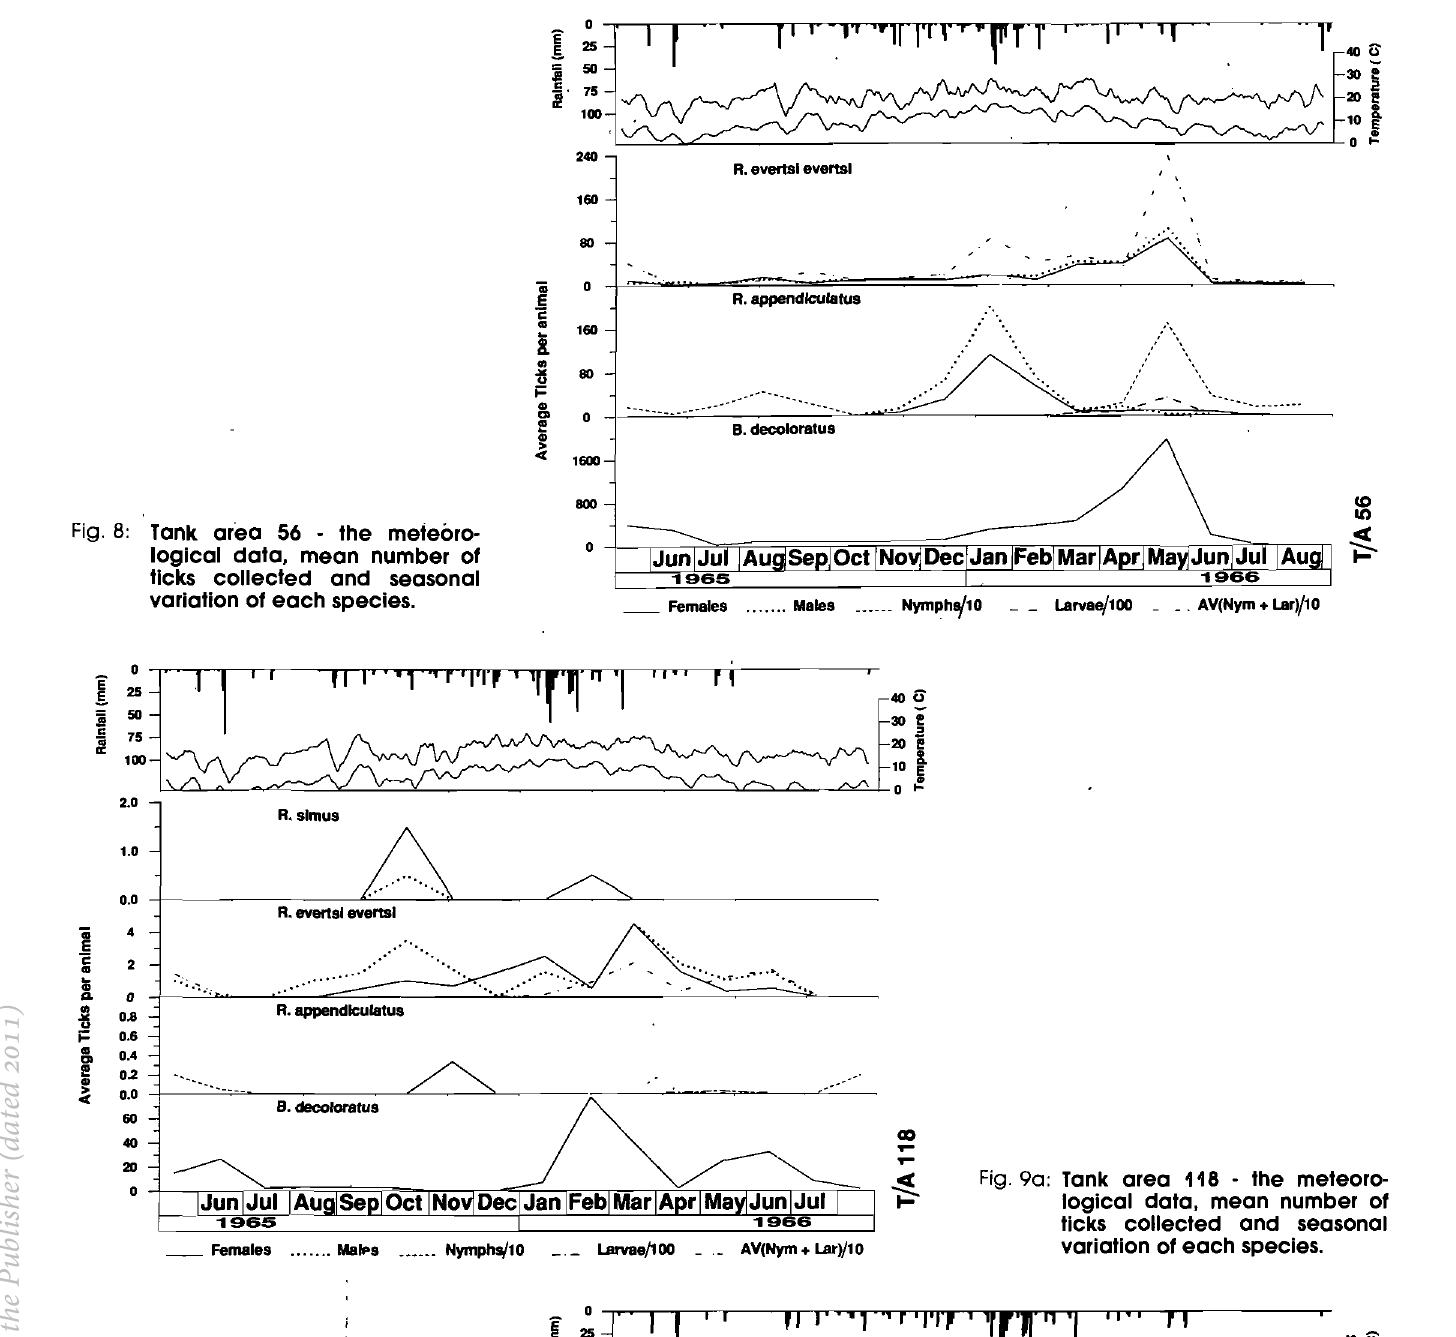
Fig. 90: Tank area 118 - the meteoro logical data. mean number of ticks collected and seasonal variation of each species.